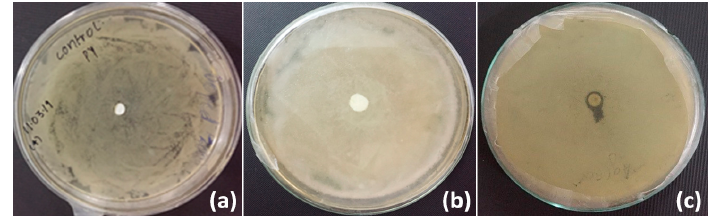
Figure 10. Antimicrobial test for SF as control ( a ), SH ( b ), and zinc oxide coated silk hydrogel (SH-ZnO). (SH-ZnO) ( c